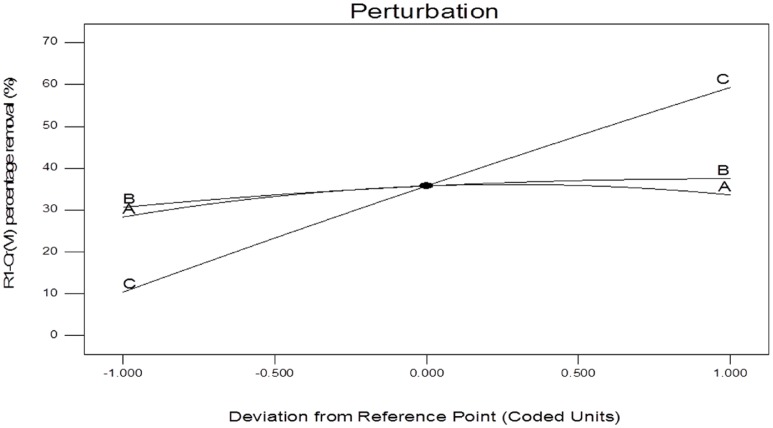
Overlay plot of perturbation of the three variables tested.